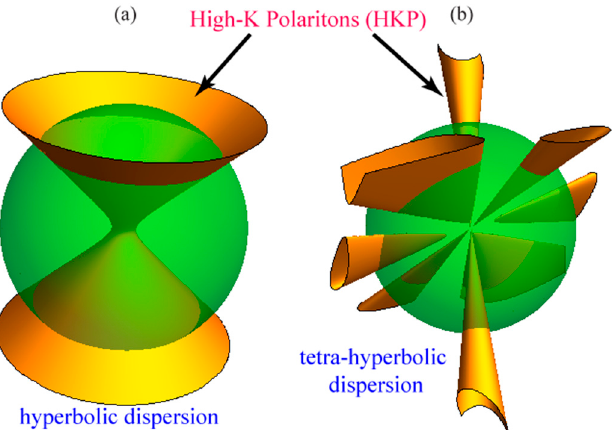
Figure 1. Isofrequency k-surface in k-space with high-k polaritons (HKPs) in a conventional monohyperbolic material ( a ) and a tetra-hyperbolic material ( b ) introduced in this paper and described in detail in the discussion below.